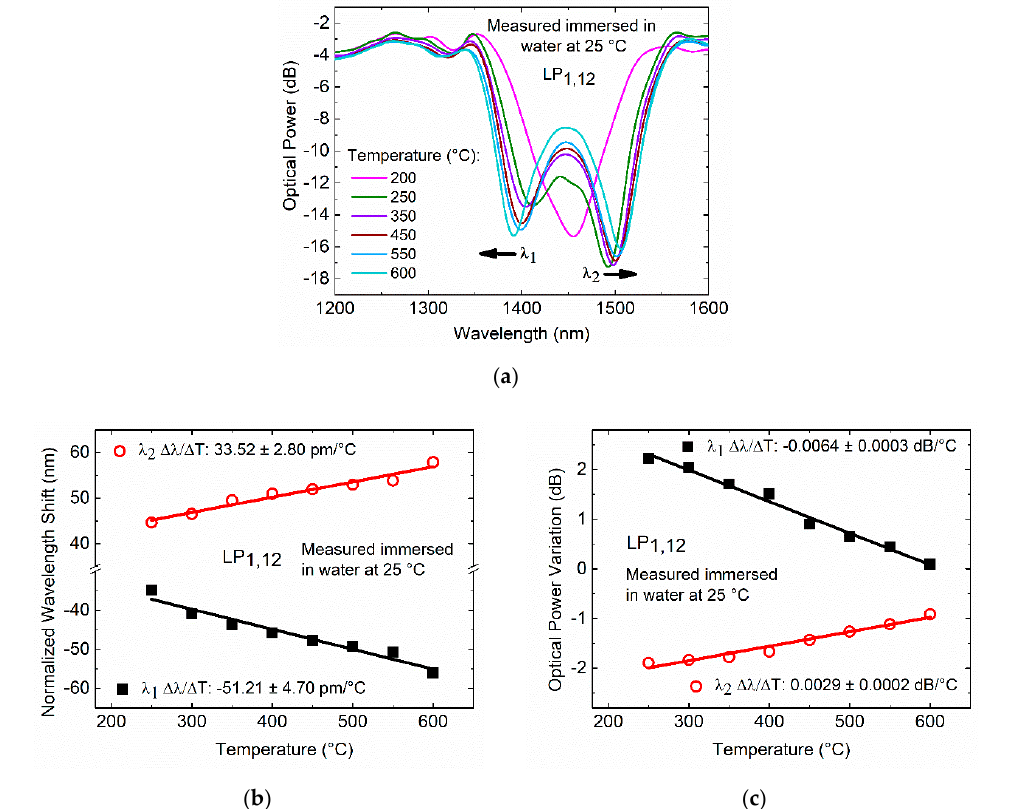
Figure 11. Fs laser TAP LPFG inscribed with a period of 192.5 µm measured in water at 25 °C: ( a ) transmission spectra after annealing at different temperatures, ( b ) normalized wavelength shift, and ( c ) normalized optical power variation.